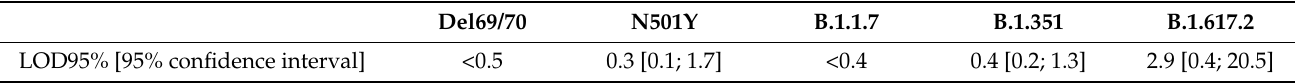
Table 3. Assessment of the limit of detection (LOD95%) of the different variant specific primer